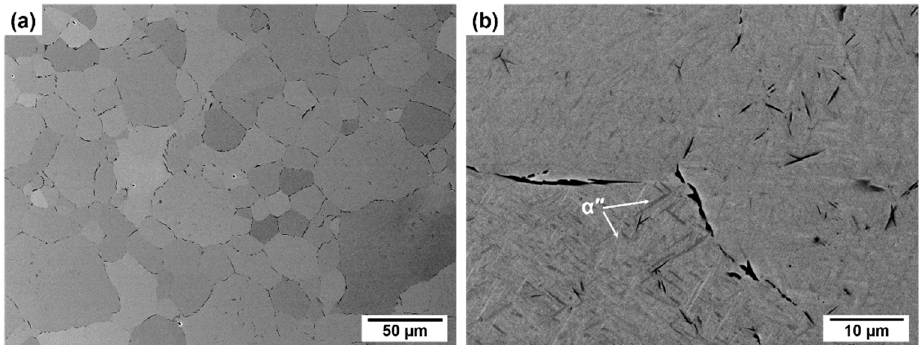
Figure 3. Typical SEM/BSE microstructure of the investigated materials on example of Ti-8Nb- 2Mo alloy at lower ( a ) and higher ( b ) magnification.